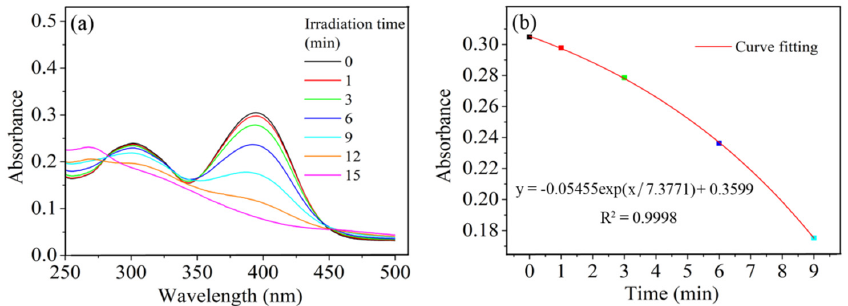
Figure 6. ( a ) UV degradation characteristics of molecule BM-PPPM-C6 at a concentration of 1 × 10 − 5 mol/L. ( b ) Photodegradation versus time fitting curve.